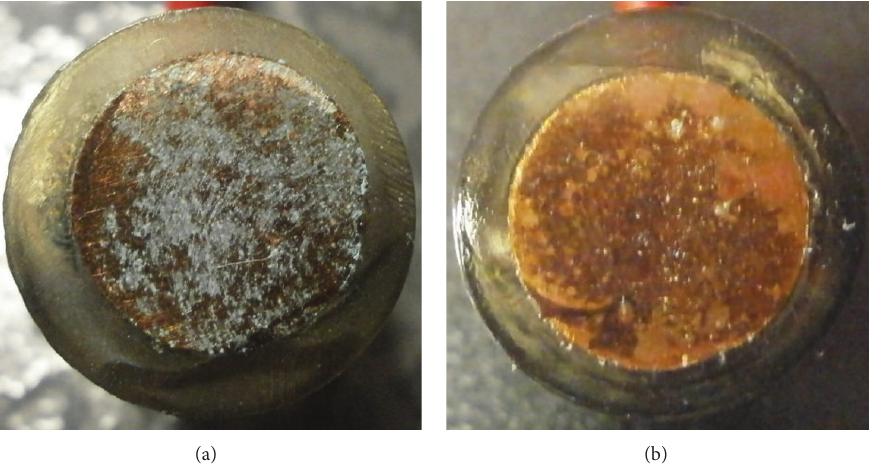
Figure 11: Macroscopic aspect of coupons coated after two weeks in the aggressive solution: (a) varnish and (b)